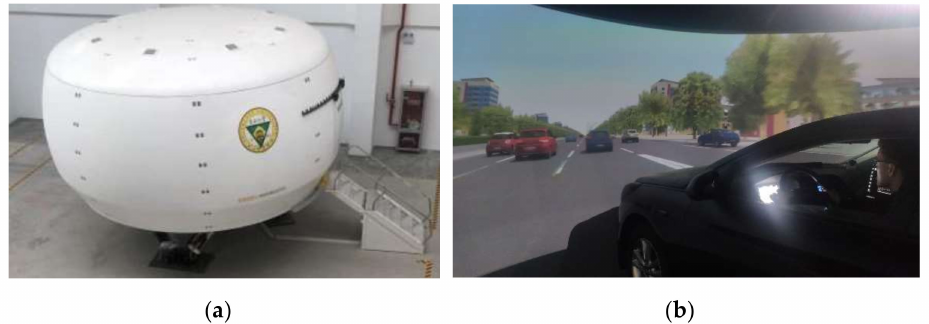
Figure 2. ( a ) Driving simulator; ( b ) screenshot in driving